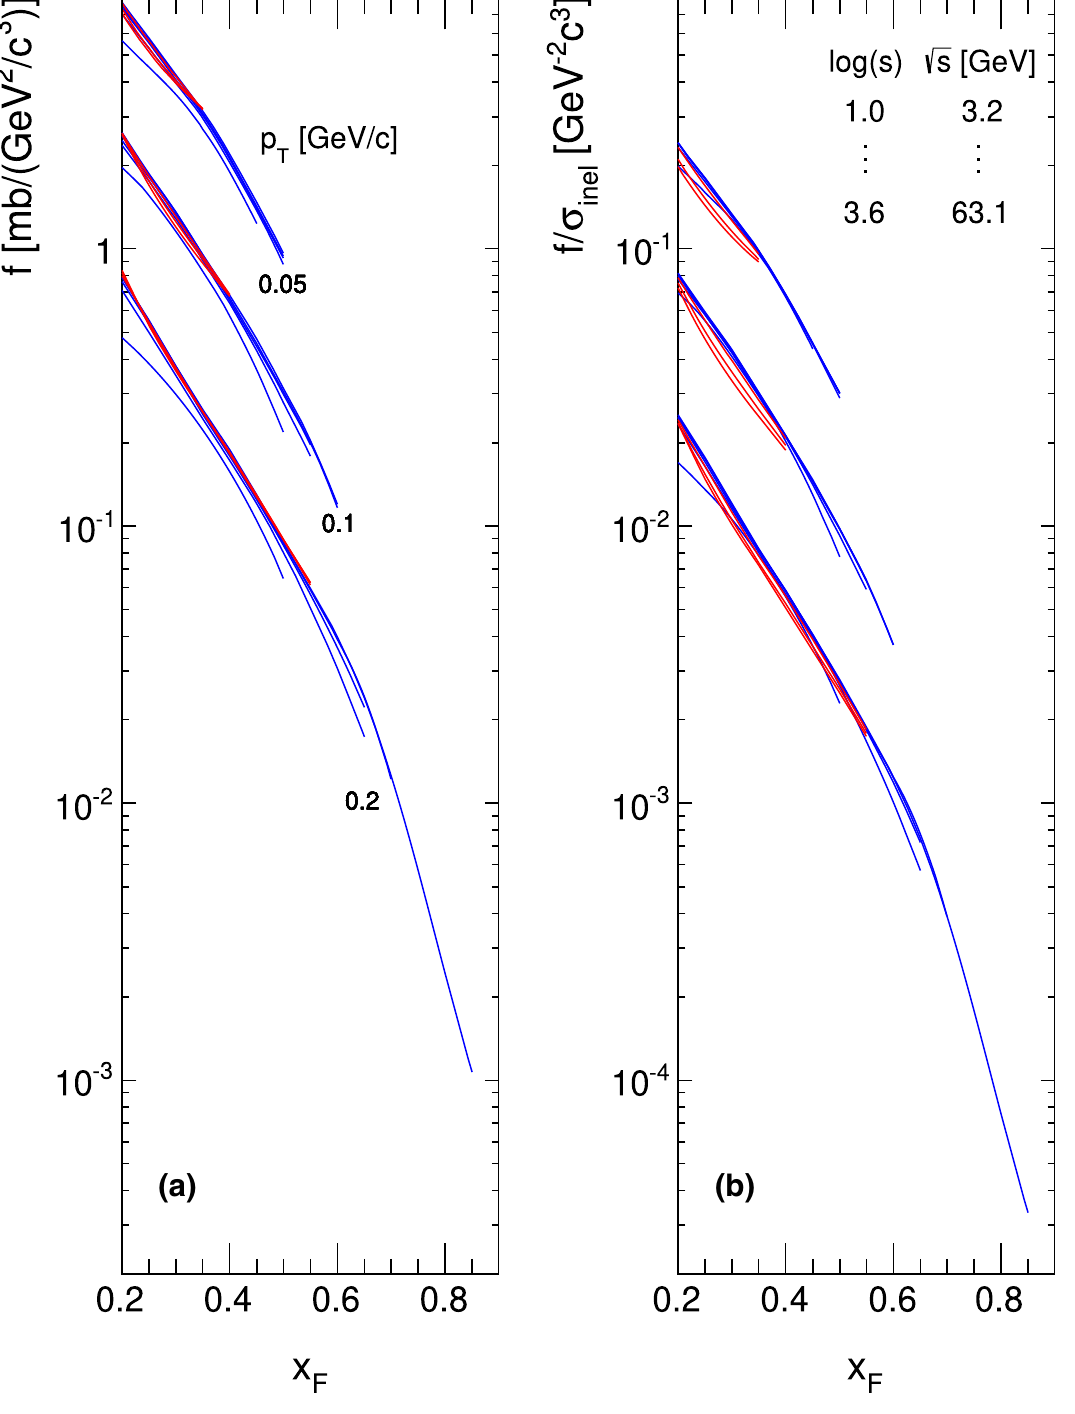
Fig. 112 a f ( x F , p T ) as a function of x F for p T = 0.05, 0.1 and 0.2 GeV/c for the global interpolation at log ( s ) values from 1.0 to 3.6. The lines at subsequent p T values are scaled down by 1/3 for better separation. b f ( x F , p T )/σ